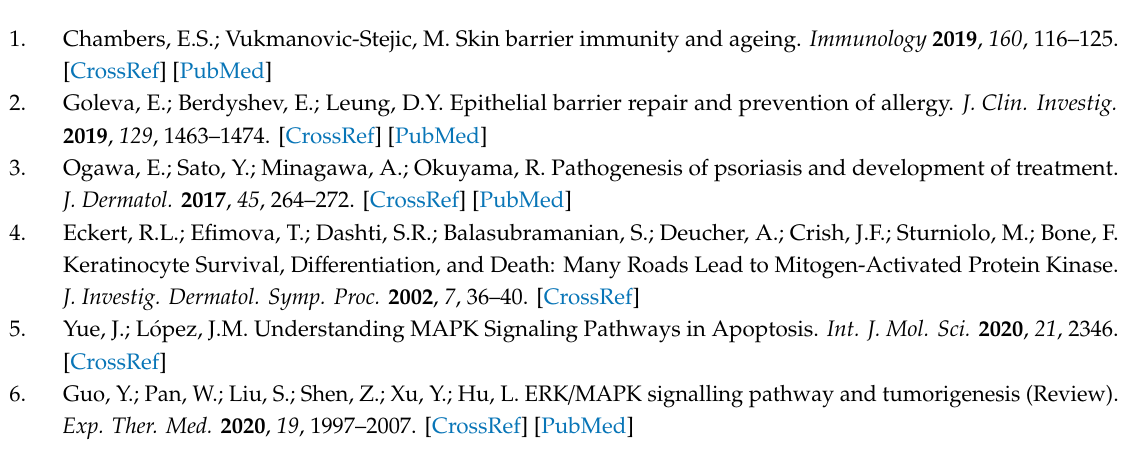
Figure S1: HPLC chromatogram of the aqueous extract from C. sudachi peel; Figure S2: E ff ects of some phenolic compounds included in SPE on ERK1 / 2 phosphorylation at the high